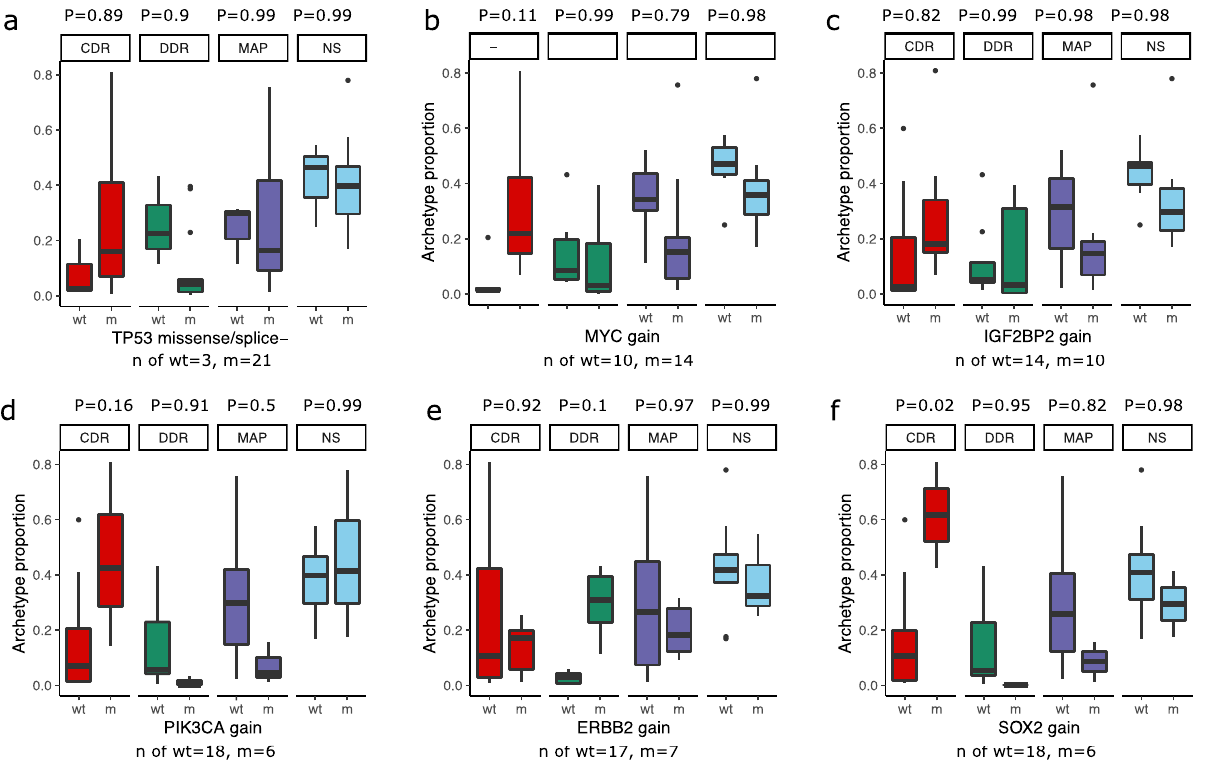
Fig. 7 Archetype proportions in samples grouped by mutations in key genes. a – f Boxplots showing the distribution of the proportion of each archetype specialist grouped by mutations that are considered pathogenic and appeared in at least 25% of the samples (6 out of 24). The boxes are grouped and colored by archetype, with red indicating CDR, green showing CDR, dark blue indicating MAP, and light blue showing non-specialists. The wt group label indicates samples with wild-type (or copy-neutral) gene, while m represents samples with a mutated (or ampli fi ed) gene with n of samples indicated at the bottom of each panel. The P value annotations above each archetype label indicate adjusted pairwise P values from Tukey ’ s HSD (single-sided) post hoc analysis of the ANOVA model of the proportion of specialists with mutation status as an interaction term. The lower and upper hinges in the boxplot indicate 25th and 75th percentiles and middle indicates 50th percentile (median), while the whiskers extended over 1.5× interquartile